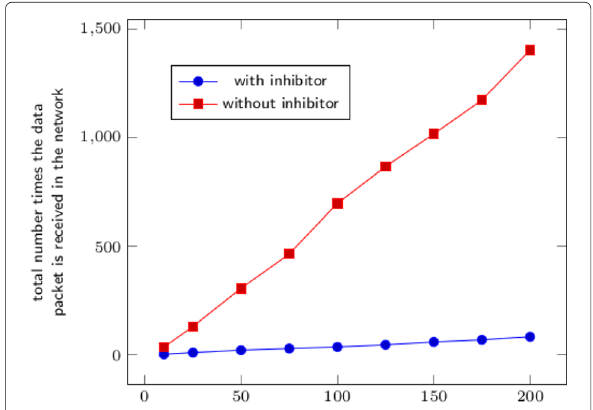
Fig. 26 Number of redundant rebroadcasts until the end of all events in CA protocol with and without inihibition